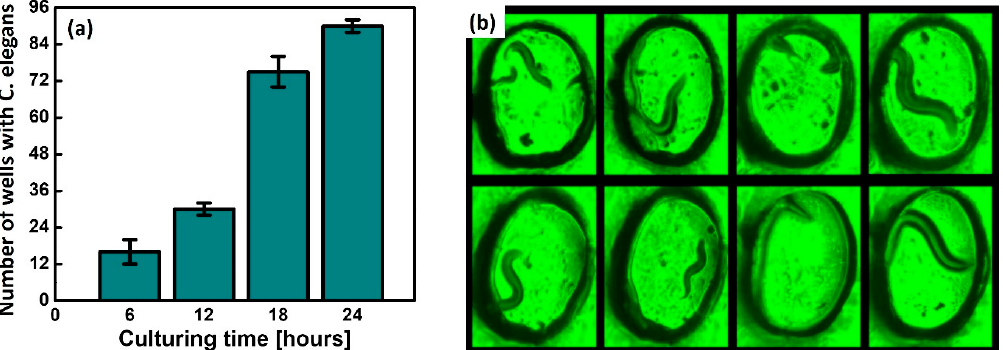
Figure 3. ( a ) Number of wells filled with cultured worms and ( b ) microscopic images of trapped C. elegans .